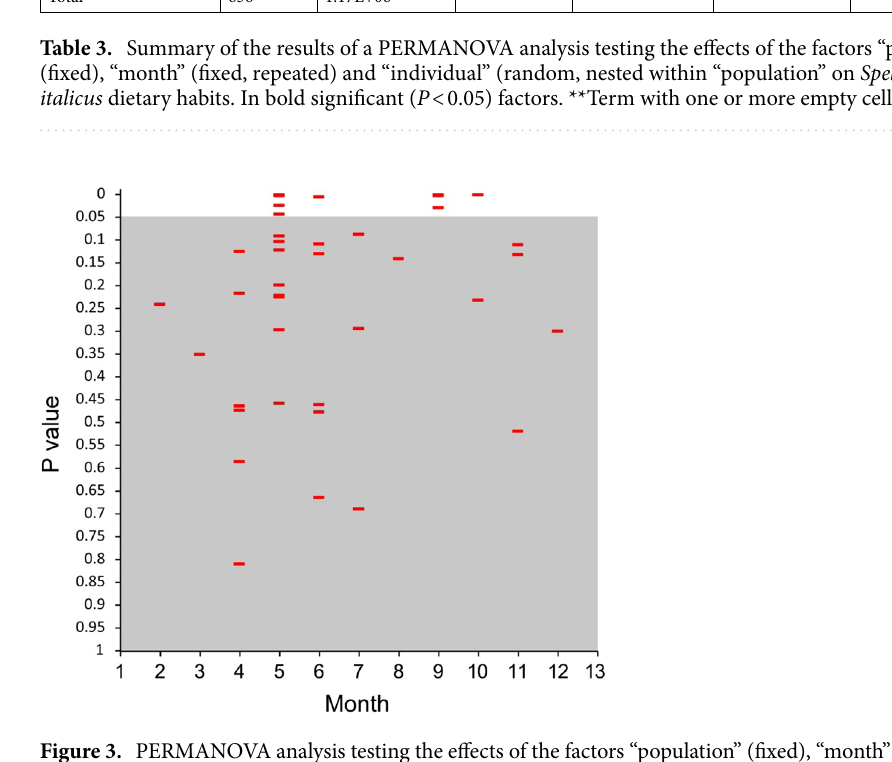
Figure 3. PERMANOVA analysis testing the effects of the factors “population” (fixed), “month” (fixed, repeated) and “individual” (random, nested within “population”) on Speleomantes italicus dietary habits: results of the pair-wise tests performed on the 46 possible combinations population/month. Noticeably, only16 were statistically significant ( P < 0.05), and occurred in the months May–June and